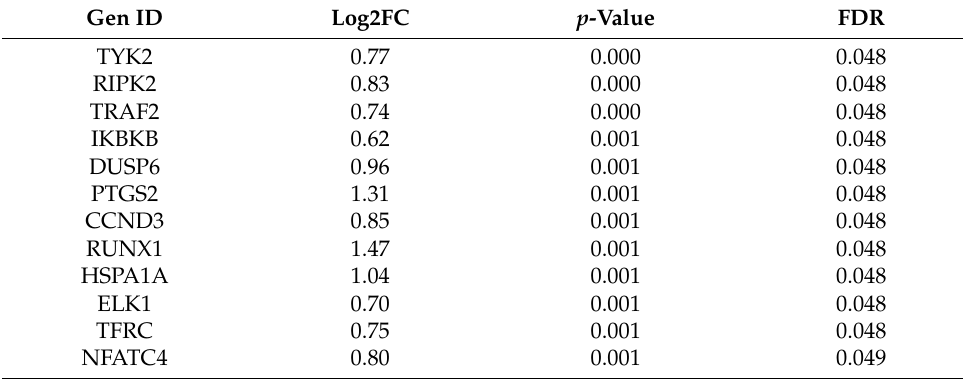
Table 4. Genes significantly expressed in patients with high NLR versus low